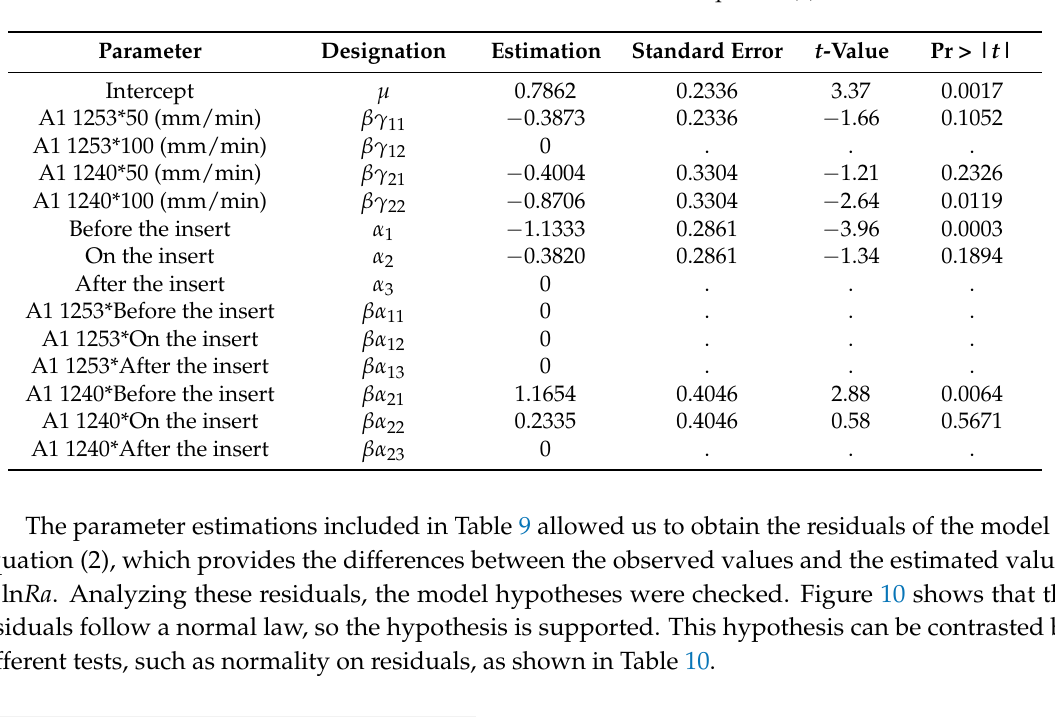
Table 9. Parameter estimations of the model in Equation (1).